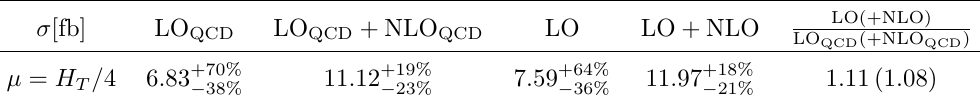
Table 5 . Cross section for pp ! t (cid:22) tt (cid:22) t at 13 TeV in various approximations.